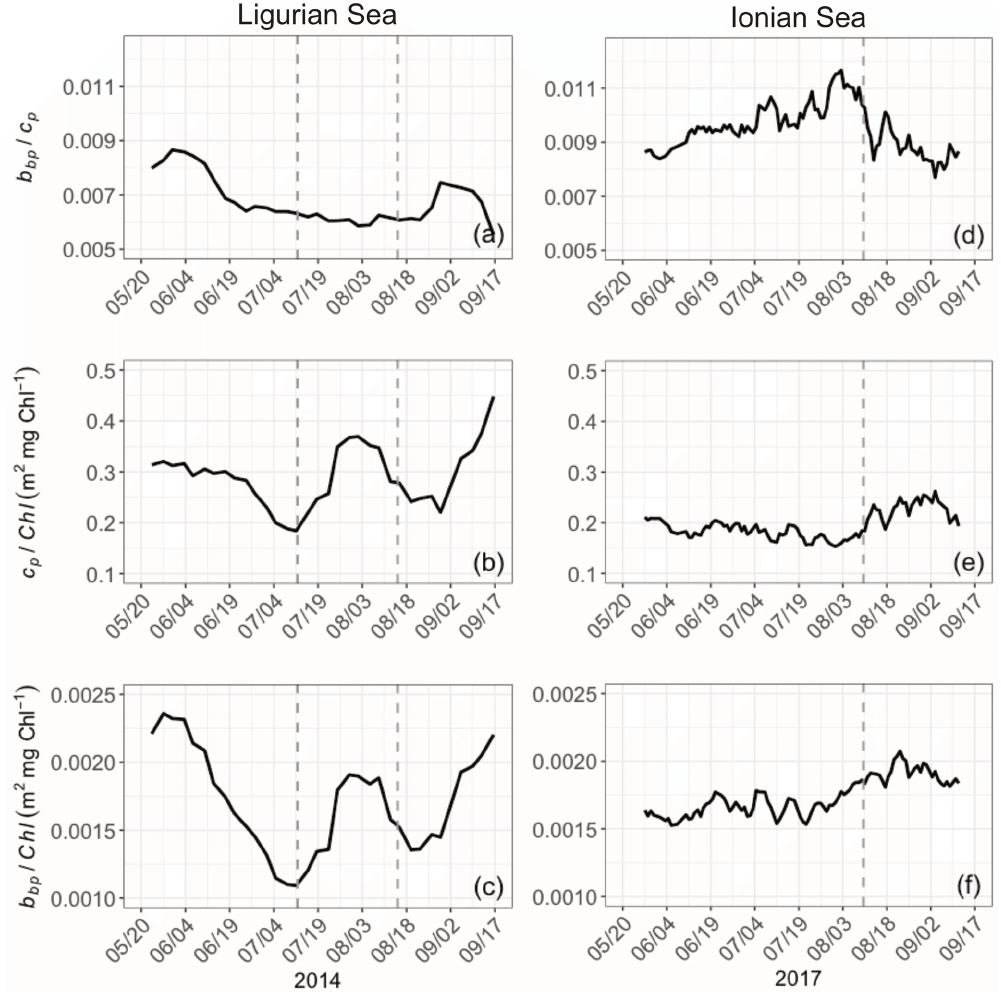
Figure 9. Temporal evolution of the bio-optical ratios of b bp /c p (a) , c p / Chl (b) and b bp / Chl (c) in the SCM layer for the Ligurian Sea (a–c) and the Ionian Sea (d–f) . The dotted lines indicate the dates when the values of c p in the SCM layer reach a minimum. Please note that the date format in this figure is